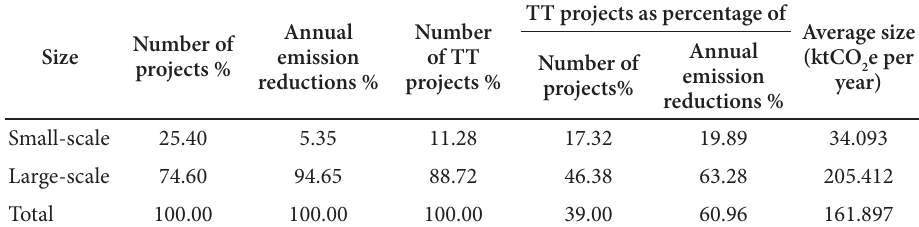
Table 1. Project size